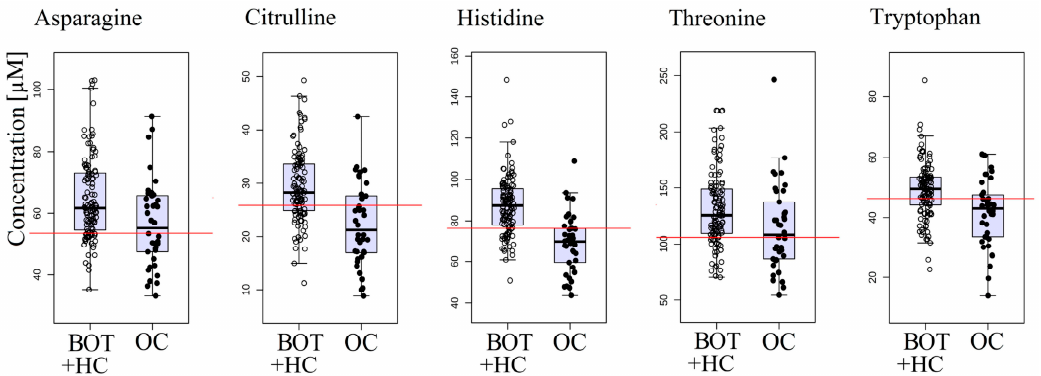
Figure 2. Serum concentrations of 5 amino acids that obtained the lowest p -value in the comparison between ovarian cancer (OC) patients and combined benign ovarian tumor (BOT) and healthy control (HC) group. The optimal cutoff values based on univariate ROC curve analysis are overlaid on the box-plots.